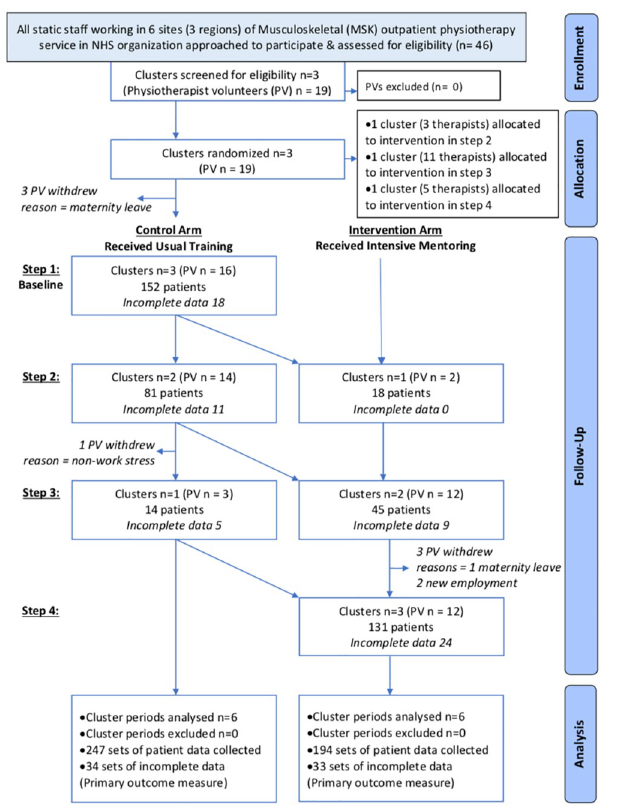
Fig 1. Modified CONSORT 2010 flow